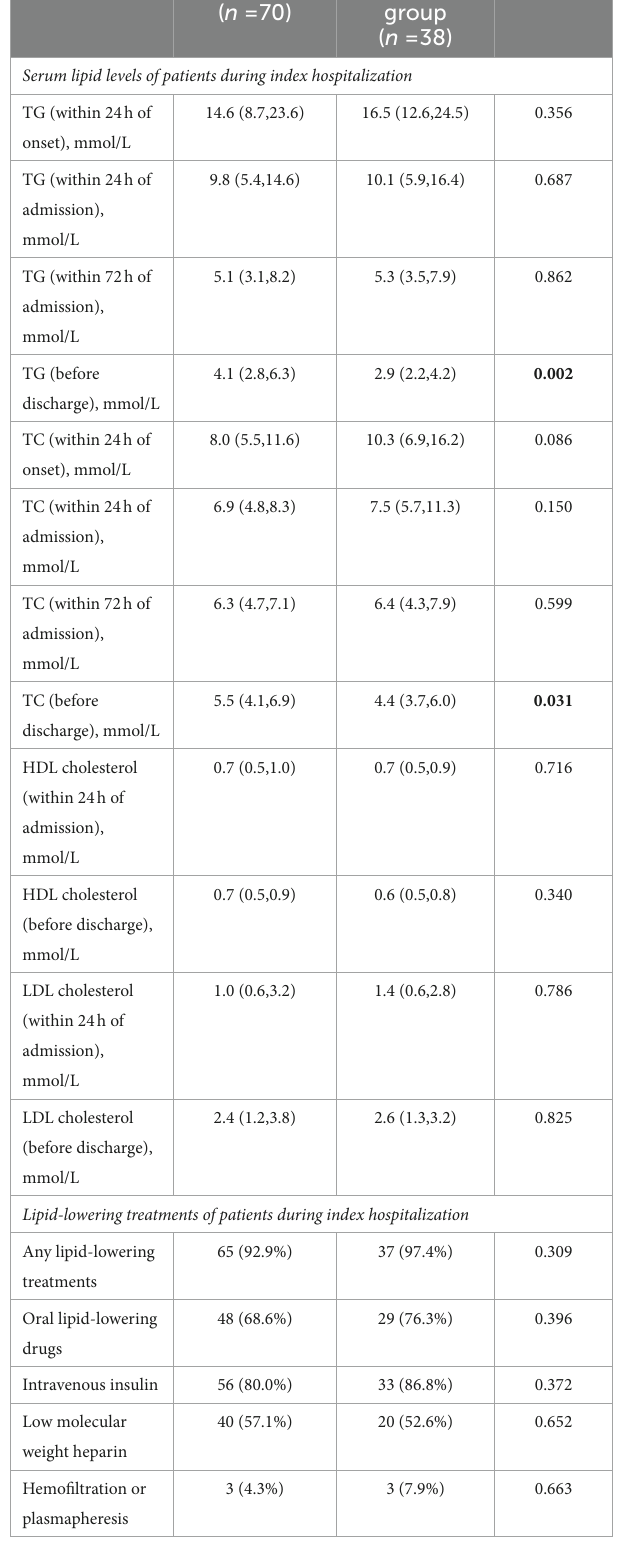
TABLE 3 Serum lipid levels of patients with HTGP during follow-up. After